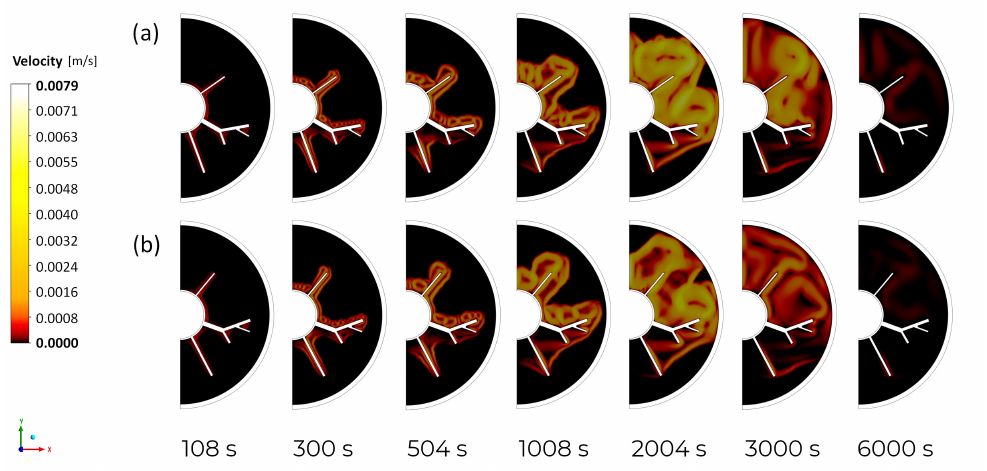
Figure 8. Contours of and streamlines during melting for ( a ) DP No. 4, ( b ) DP No.